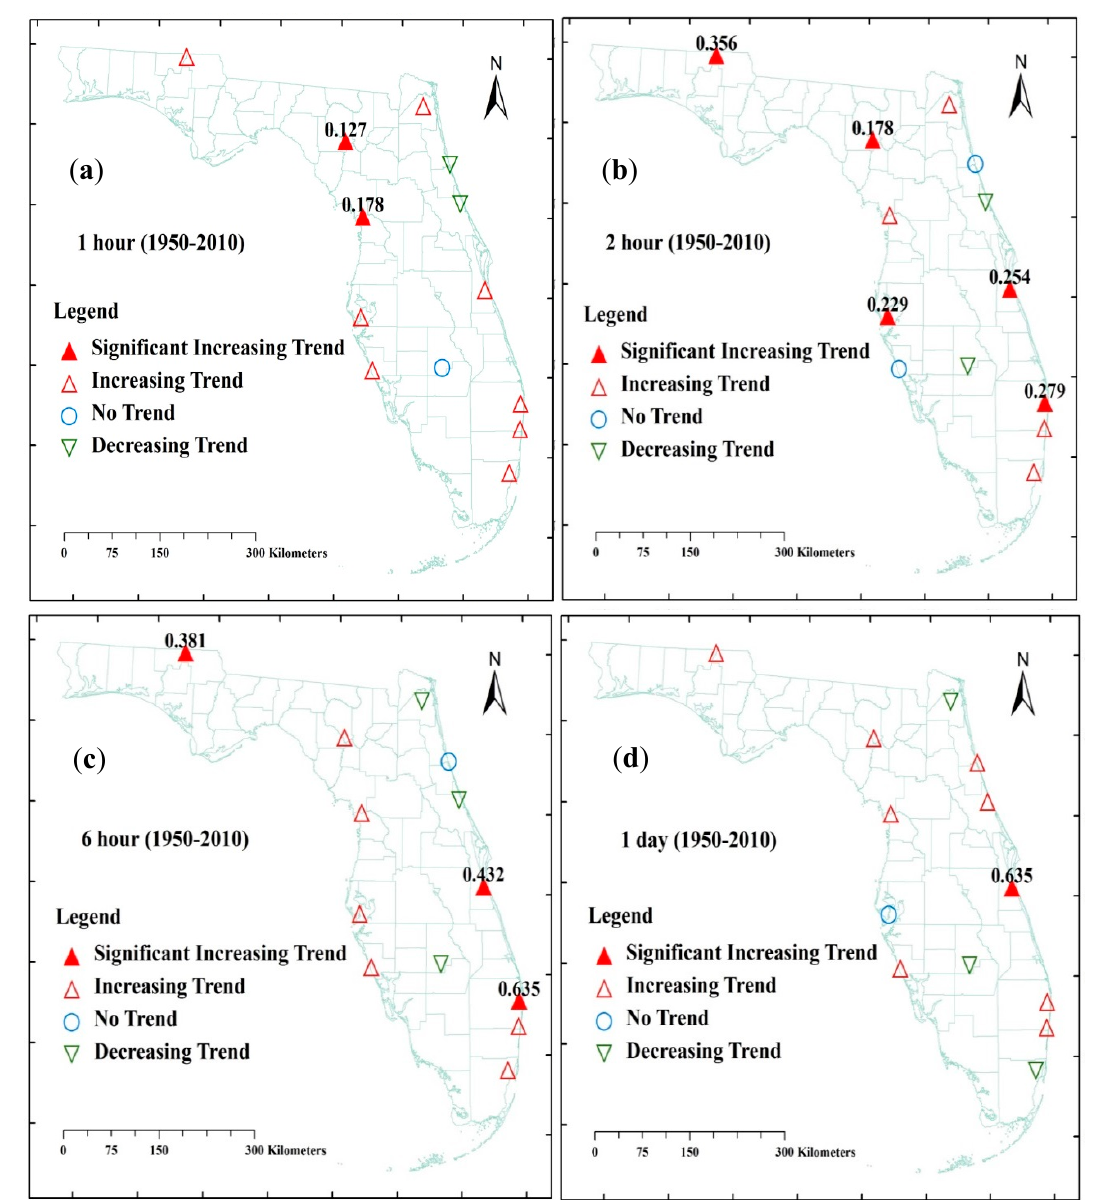
Figure 3. Spatial pattern of the trend results for the annual maximum rainfalls of ( a ) 1 h, ( b ) 2 h, ( c ) 6 h, and ( d ) 1 day durations for the 1950–2010 analysis period. The slope value (mm/year) for locally significant trend is also indicated.